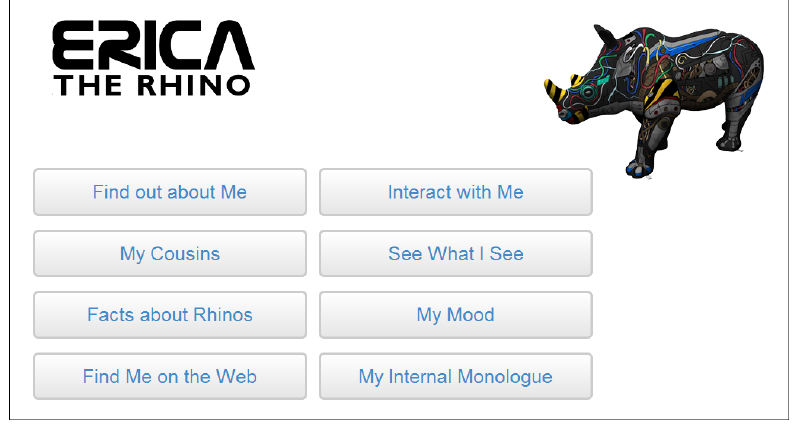
Figure 12. The home screen on the tablets in Erica’s side.